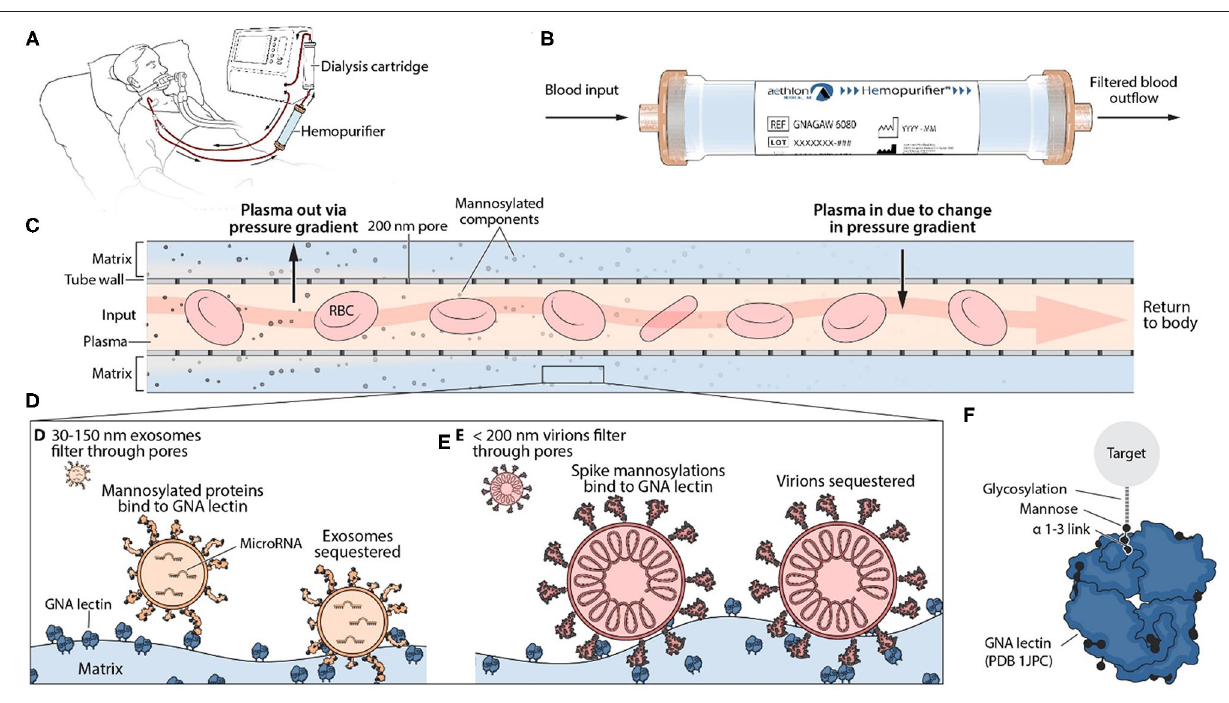
Frontiers in Medicine |